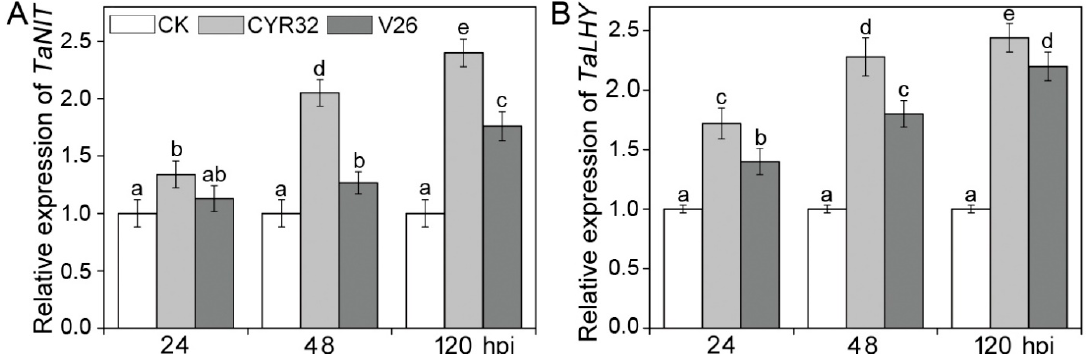
Figure 6. Expression profiles of TaNIT ( A ) and TaLHY ( B ) in wheat cultivar CM42 inoculated with CYR32 and V26. The TaActin gene was used as a positive control. The relative expression of two genes was calculated by using the comparative threshold (2 −ΔΔ C t ) method. Bars represent standard deviations (SD), which were calculated from four independent biological replicates ( n = 4). Different letters note significant differences among different treatments ( p < 0.05) following Duncan’s multiplication range test. CK, un-inoculated wheat plants. 24–120 hpi represent 24, 48, and 120 h post- inoculation.